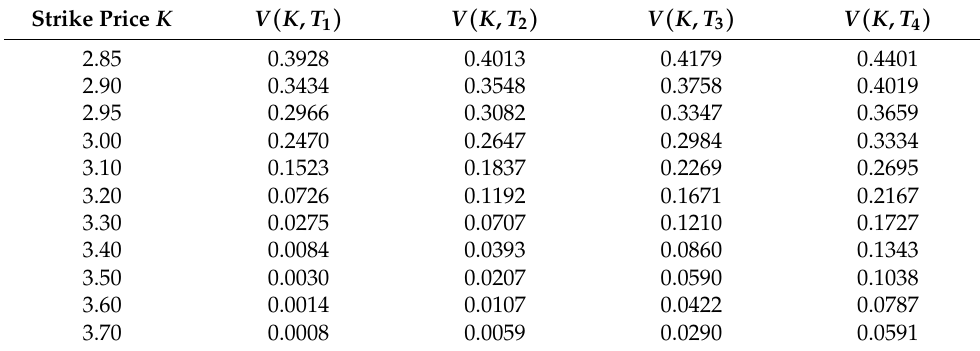
Table 4. The SSE 50ETF option price at 9 September 2021.